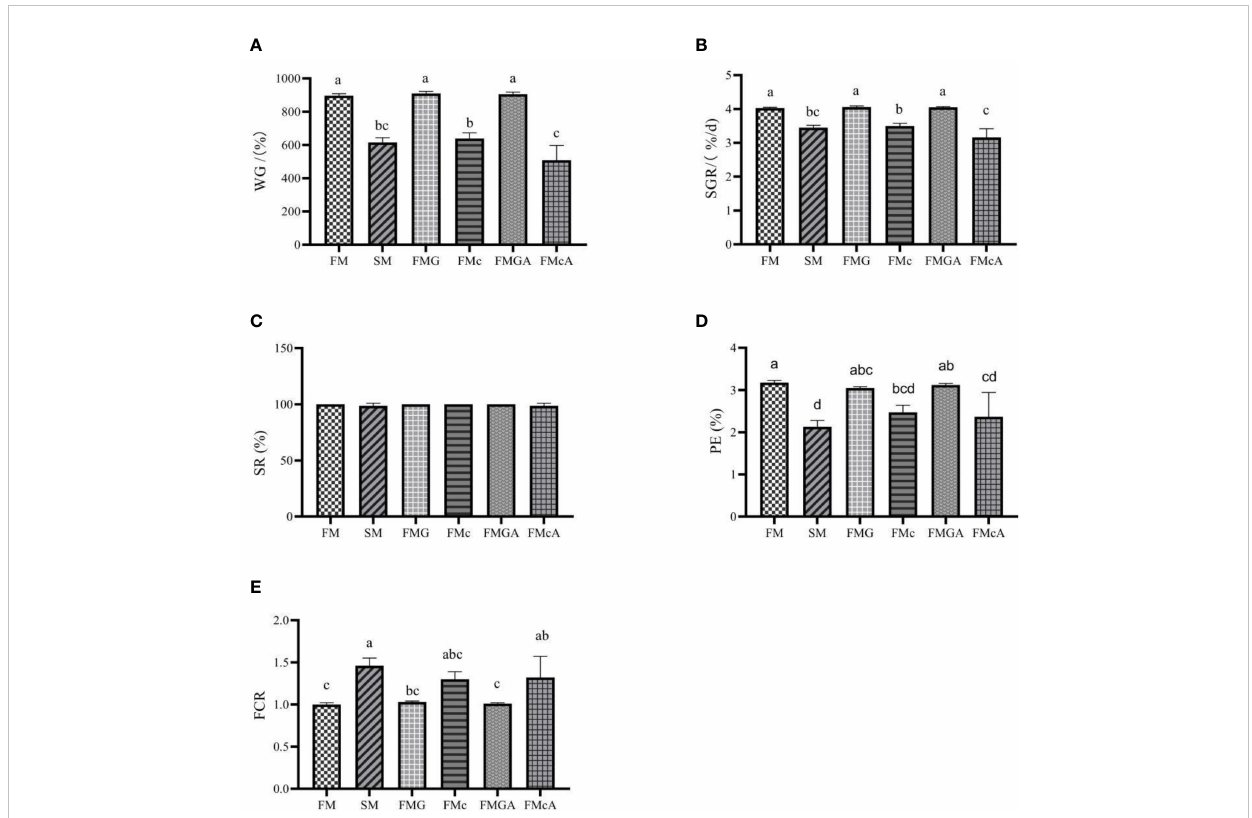
FIGURE 1 Growth performance of mirror carp at different treatments fed with dies containing fi shmeal (FM), soybean meal (SM), glycinin (FMG), B-conglycinin (FMc), AKG+glycinin (FMGA), AKG+B-conglycinin (FMcA) after eight weeks. (A) WG, weight gain (%); (B) SGR, speci fi c growth rate (%/day); (C) SR, survival rate (%); (D) PE, protein ef fi ency (%); (E) FCR, feed conversion ratio; Data are presented as mean + SE, (n = 3). a, b, c Mean values with different letters were signi fi cantly different